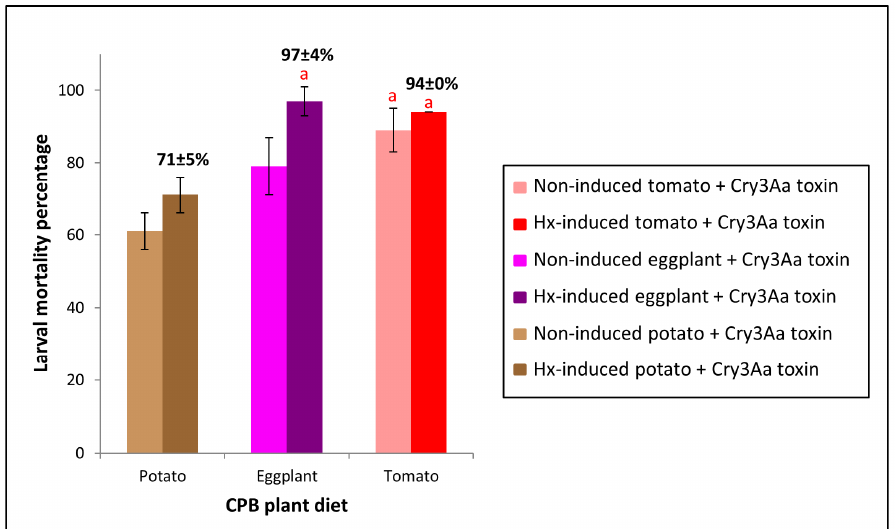
Figure 5. Mortality percentage of CPB larvae fed Hx-induced potato, eggplant or tomato versus CPB larvae fed non-induced plants, following challenge with Cry3Aa toxin. Error bars represent standard error of the mean of three biological replicates ( n = 3) of each sixteen CPB larvae. Means followed by the same letter were not significantly different (Student’s t -test, p >